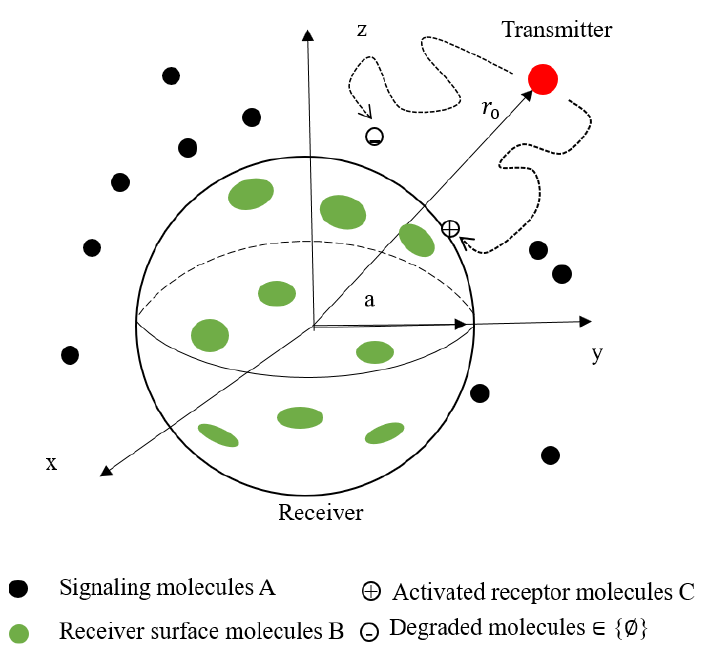
Figure 2. System model of diffusive molecular